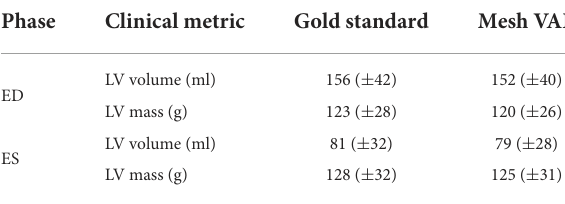
TABLE 3 Clinical metrics of generated and gold standard mesh